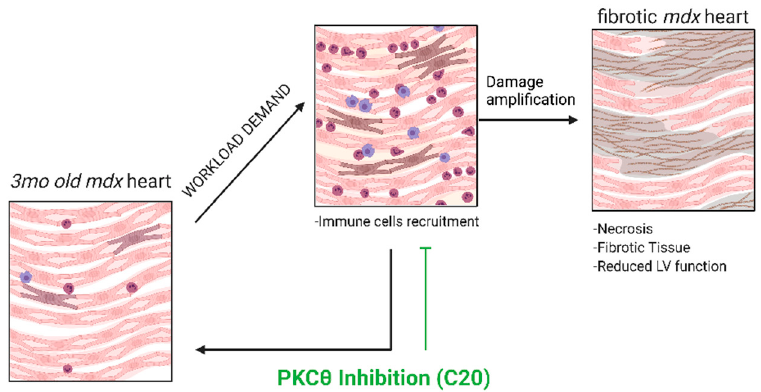
Figure 7. Proposed mechanism of C20 effect. The loss of functional dystrophin causes cardiomyocytes sarcolemma leaks in response to cardiac workload (mimicked by the exercise protocol), promoting immune cells infiltration. Immune cell infiltration amplifies cardiac damage, leading to exacerbated fibrotic tissue deposition. C20 treatment, inhibiting T cells activity, blunts the inflammation in response to CMCs cell death, leading to a decrease in myeloid infiltration and protecting the tissue by the amplification of the damage.